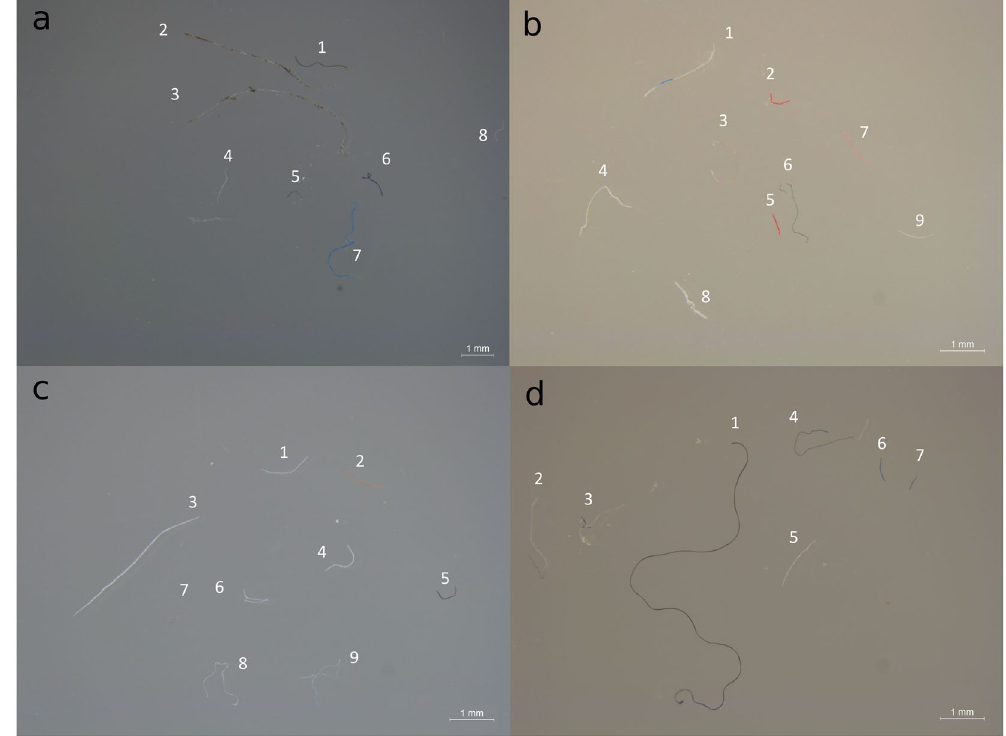
Figure 1. Photographs of representative marine microdebris in juvenile coral trout. Marine microdebris was detected in the gastrointestinal tract of 20 individual juvenile coral trout ( Plectropomus leopardus and P. maculatus ) collected on reefs around ( a ) Lizard Island, ( b ) Orpheus Island, ( c ) Heron Island, and ( d ) One Tree Island, in the Great Barrier Reef World Heritage Area, Australia, in 2011. Examples of chemical type assignments for marine microdebris include: ( a ) semi-synthetic : cellulose-derived (4), NFPC: nylon (5); naturally-derived : cellulose-natural (1, 6, 7); ( b ) semi-synthetic : cellulose-derived (1, 2, 3, 5, 6), NFPC: nylon (8); naturally-derived : cellulose-natural (7), keratin (4); ( c ) synthetic : polyester (8); semi-synthetic : NFPC: nylon (5, 6), NFPC: polyester (1); naturally-derived : cellulose-natural (2, 3, 9); ( d ) semi-synthetic : cellulose-derived (6), NFPC: nylon (5), NFPC: polyurethane (1); naturally-derived : cellulose-natural (4, 7), keratin (3). For the following items, natural origin (a2, a3, a8) or contamination (b9, c4) could not be ruled out. Chemical type was not assigned to fibre c7 (fibre was missing) and d2 ( < 60% match). NFPC = natural fibre reinforced polymer